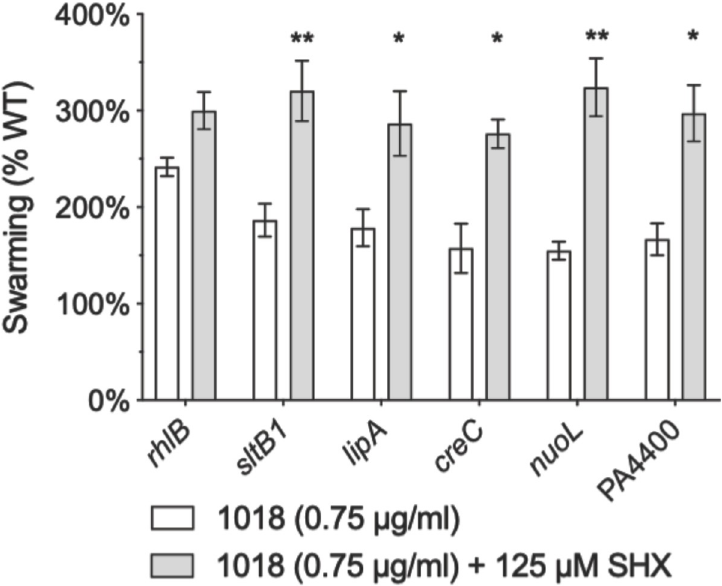
Fig 6. SHX enhanced the swarming phenotype of peptide 1018-tolerant transposon insertion mutants. BM2 swarm plates (+ 0.75 μ g/ml 1018) were inoculated with 1 μ l of planktonic cells suspended at an OD 600 of 0.4–0.6 in BM2 and then incubated for 20 h at 37˚C (A) Peptide-tolerant mutants showed enhanced swarming in the presence of SHX (125 μ M). Mean and standard error of the mean are shown. Two-tailed student t -tests were used to determine statistical significance between treatments with or without SHX. � P < 0.05, �� P < 0.01. (B) Representative image of peptide-tolerant mutants swarming in the presence of SHX and peptide. Each experiment had at least three biological